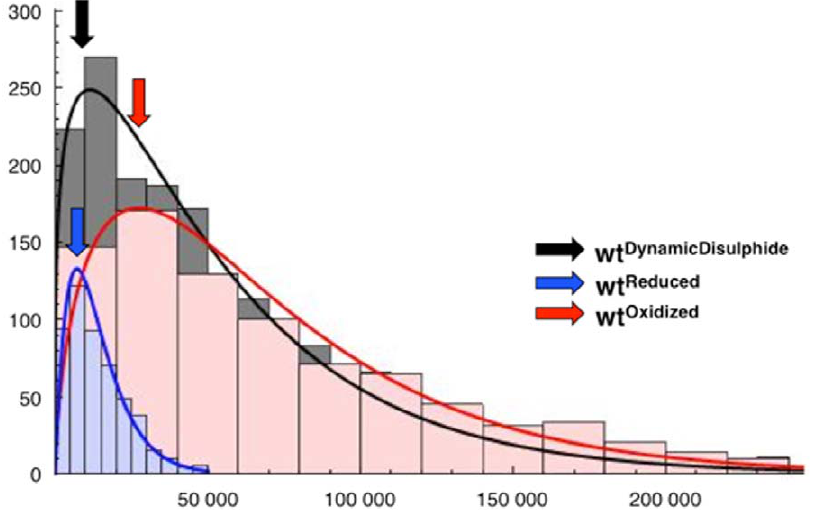
Figure 4. The distribution of the kinetic folding times described by a Gamma function [ 85,86 ] . The fit is colored according to; wt DynamicDisulphide (black), wt Reduced (blue) and wt Oxidized (Red). The most probable folding time, P t , (the position of the maximum of the fit) and the shape of the fit obtained for each model is shown in Table 1. P t corresponds to the main folding route and is in the same range for the wt DynamicDisulphide and wt Reduced models. However, the tails of the distributions for these models are significantly different. In the case of the wt Oxidized model P t is three times bigger then for the wt Reduced route and the tail distribution is similar to the wt DynamicDisulphide . doi:10.1371/journal.pone.0045654.g004 PLOS ONE |